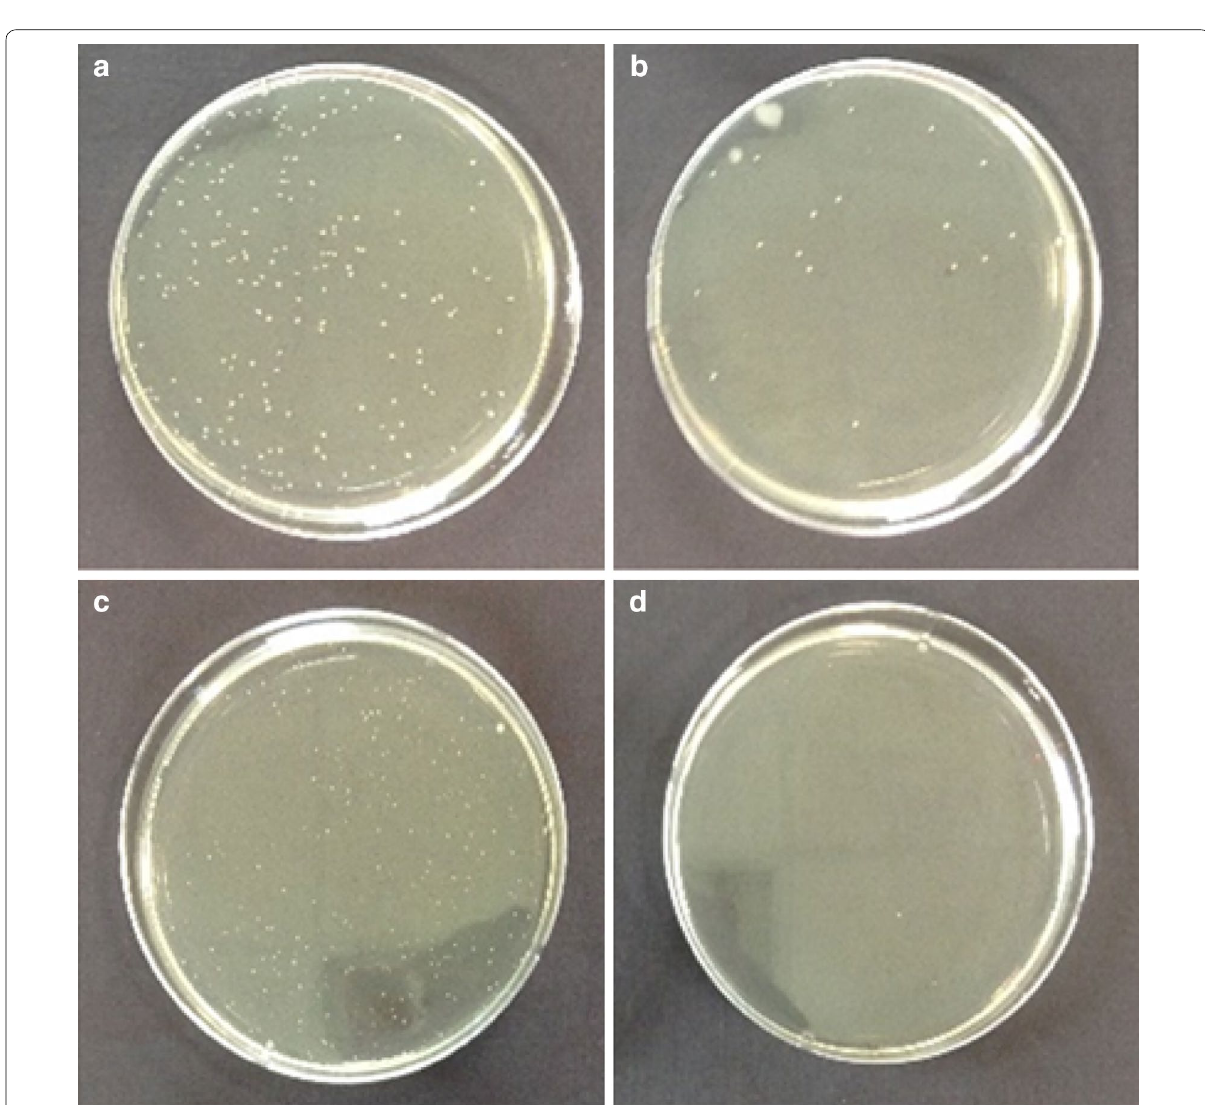
Fig. 8 Colony formations on Mueller–Hinton agar inoculated with diluted solution of the collected elution from the bacterial inoculum on the 10 3 dilution of AgNP-grown PDMS film o the agar, respec- AgNP-grown PDMS films. a , b E. coli inoculum of 1 10 5 dilution of the control and 1 × × tively. c , d S. aureus inoculum of 1 10 4 dilution of the control and 1 dilution of AgNP-grown PDMS films, × ×